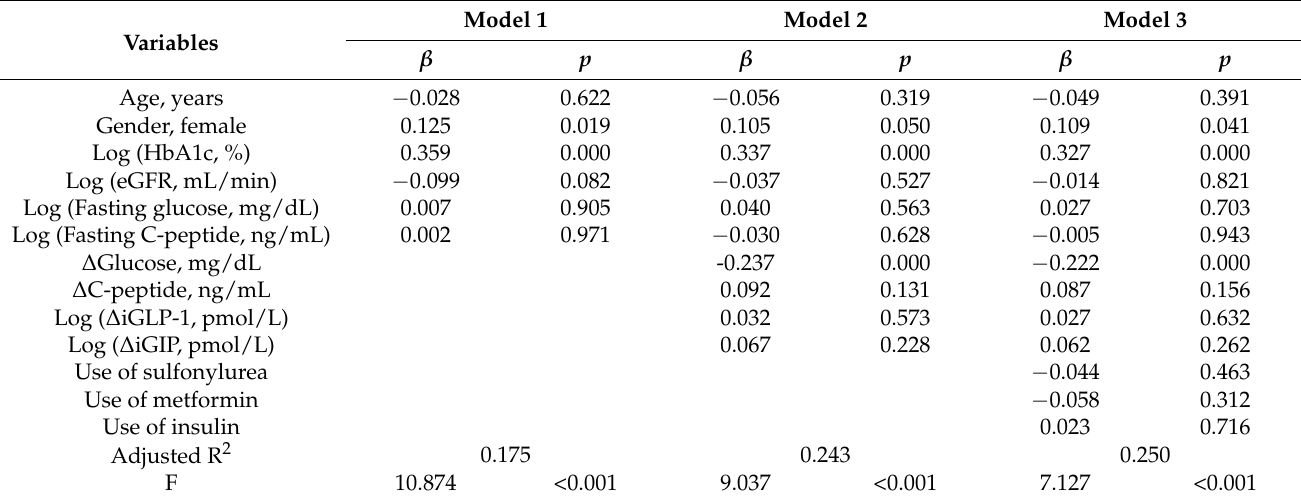
Table 4. Hierarchical multiple regression analyses predicting ∆ glucagon